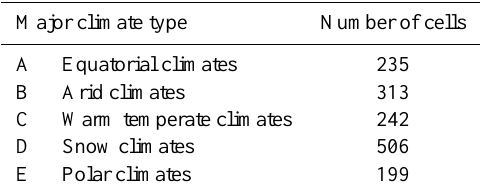
Table 1. Distribution of the selected grid cells over the K¨oppen– Geiger climate